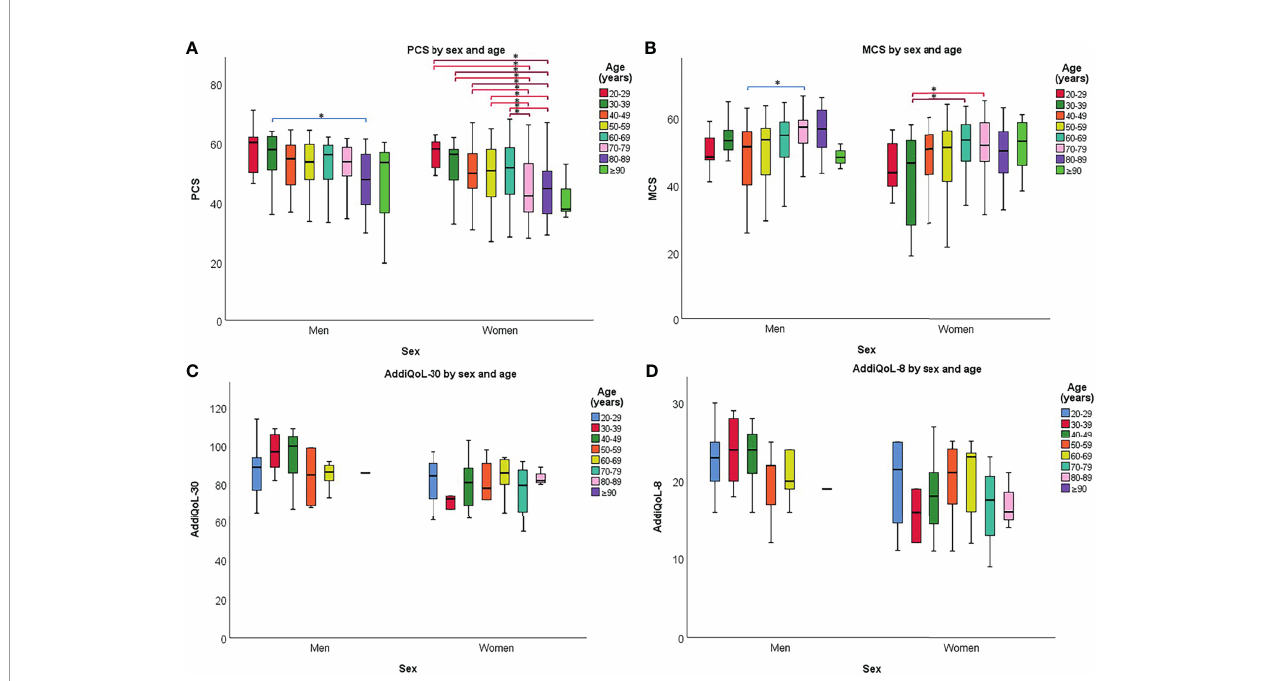
FIGURE 3 | Physical component summary (PCS) (A) , mental component summary (MCS) (B) , AddiQoL-30 (C) , and AddiQoL-8 (D) scores in different age groups for men and women separately. The box marks the interquartile range, black horizontal line the median, and the whiskers the range. *p <